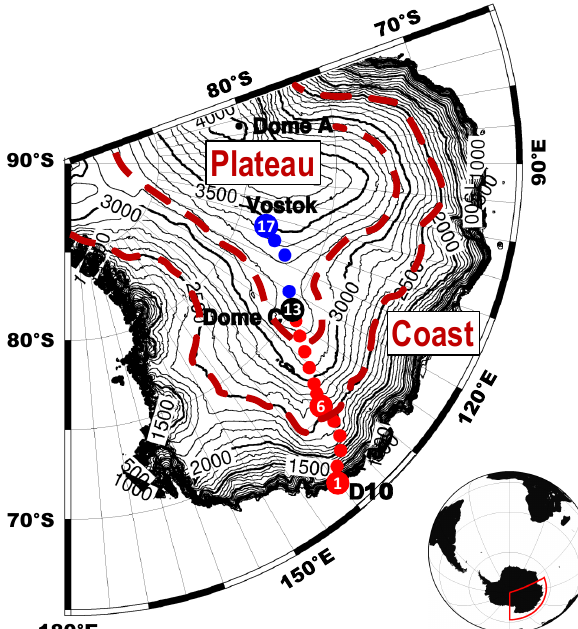
Fig. 1. Snow pit collections in 17 locations in East Antarctica. Spac- ing of the contour lines is 100m. The red and blue symbols indi- cate the locations visited during the austral summers 2007–2008 and 2009–2010, respectively. The Dome C and Vostok sites were sampled two and three times, respectively. The red dashed lines rep- resents the boundaries of the “coast” and “plateau” zones as defined in Sect.